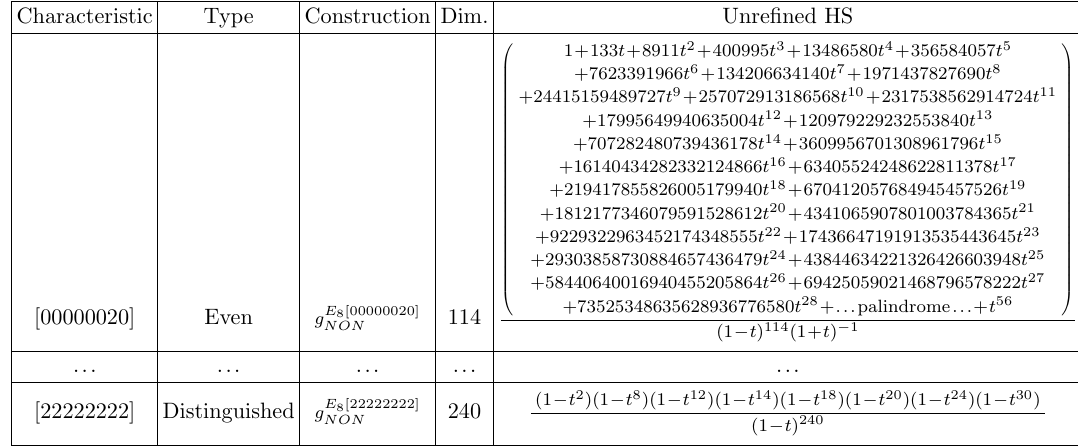
Table 29 . E 8 orbit constructions and Hilbert series (B). Orbits in the centre of the Hasse diagram remain to be